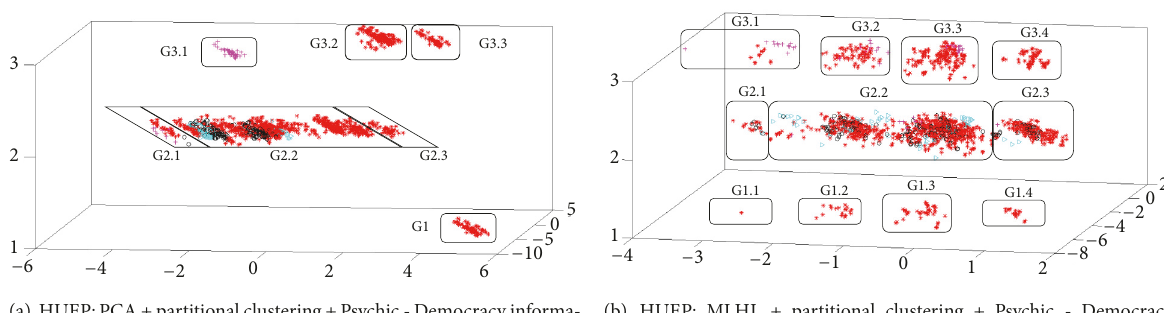
Figure 3: HUEP samples on partitional clustering ( k =3).